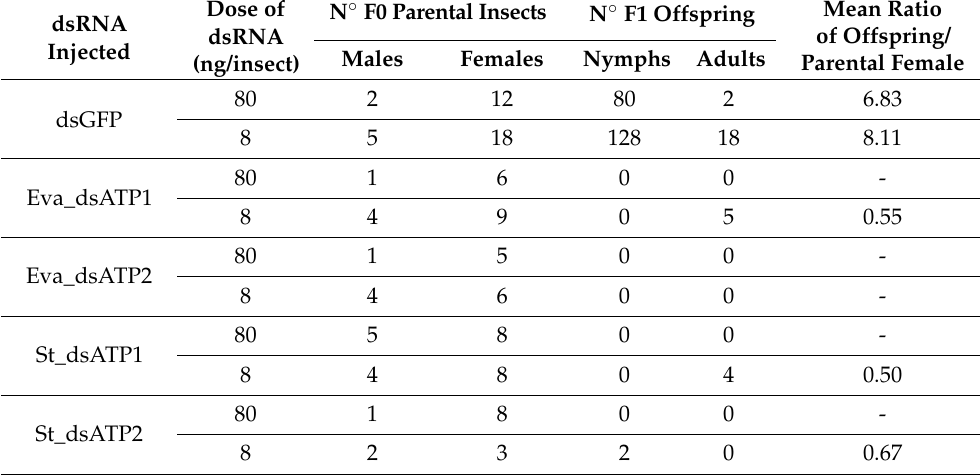
Table 3. Effects of ATP synthase β silencing on Euscelidius variegatus progeny. Numbers of offspring of E. variegatus following the injection of newly emerged F0 parent adults with different doses of dsRNAs targeting green fluorescent protein (GFP) or different portions of ATP synthase β gene of E. variegatus (Eva_dsATP1, Eva_dsATP2) and of Scaphoideus titanus (St_dsATP1, St_dsATP2). Groups of injected F0 females and males listed in the same line were caged together for 15 days right after the dsRNA injection. Numbers of males and females collected alive at the end of this period are indicated. Offspring insects (F1, nymphs, and adults) were collected 60 days post